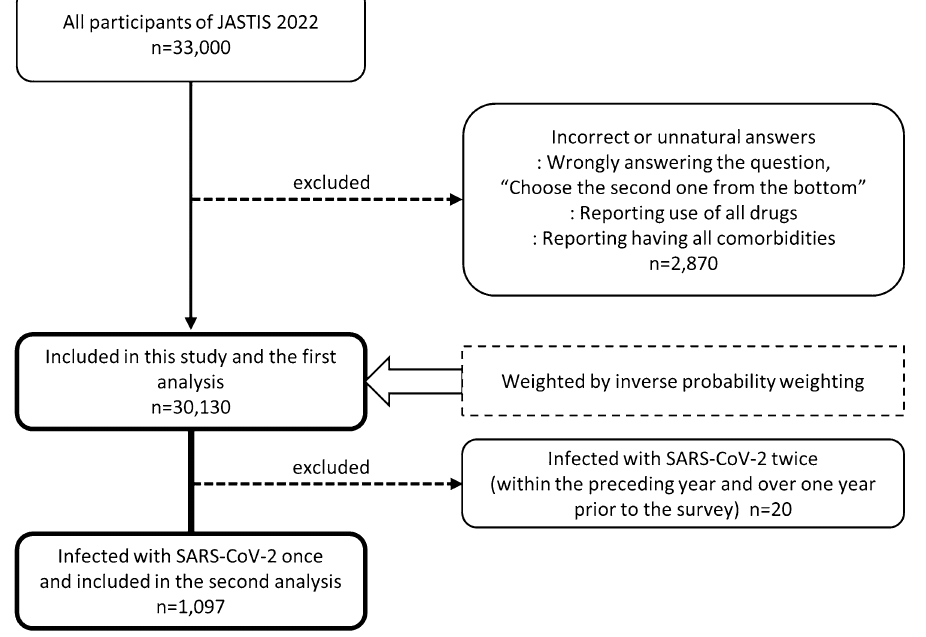
Figure 1. Inclusion flow chart. JASTIS the Japan “Society and New Tobacco” Internet Survey, SARS-CoV-2 severe acute respiratory syndrome coronavirus